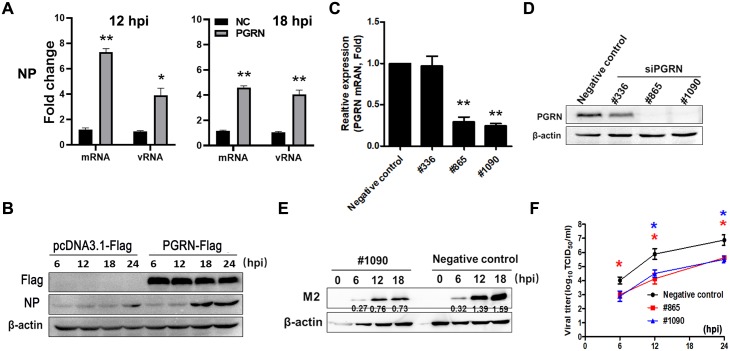
PGRN plays a functional role during influenza virus replication.(A) A549 cells were transfected with negative control (NC) or PGRN-expressing plasmids, and 24 h after transfection, cells were infected with live PR8 virus at an MOI of 1. The mRNA and vRNA of NP was analyzed by q-PCR at 12 and 18 hpi. Data are representative of three independent experiments. *p < 0.05; **p < 0.01; ***p < 0.001. (B) A549 cells were transfected with pcDNA3.1-Flag or PGRN-Flag plasmids, and 24 h after transfection, cells were infected with live PR8 virus at an MOI of 1. The NP protein in A549 cells was analyzed by western blot at 6, 12, 18 and 24 hpi. β-actin is shown as a loading control. Data are representative of three independent experiments. (C) Serum-starved A549 cells were transfected with siRNAs (either negative controls or PGRN-targeting siRNAs #336, #865 and #1090) and PGRN mRNA expression was measured 24 h later by q-PCR. Each data is representative of three independent experiments. **p < 0.01 (D) Serum-starved A549 cells were transfected with siRNAs (either negative controls or PGRN-targeting siRNAs #336, #865 and #1090) and PGRN protein level was examined 48 h later by western blot. Data are representative of three independent experiments. (E) A549 cells were transfected with siRNAs (either negative control or PGRN-targeting siRNA #865 or #1090) after PR8 infection at an MOI of 1. Viral titers were measured by TCID50 assay at the indicated time points. Each data is represented as means ± SEMs and is representative of three independent experiments. *p<0.05; **p<0.01. (F) Serum-starved A549 cells were transfected with negative control or PGRN-targeting siRNA #1090. After 48 h, the cells were infected with PR8 virus at an MOI of 1 and expression of M2 protein was measured by western blot. Data are representative of three independent experiments.